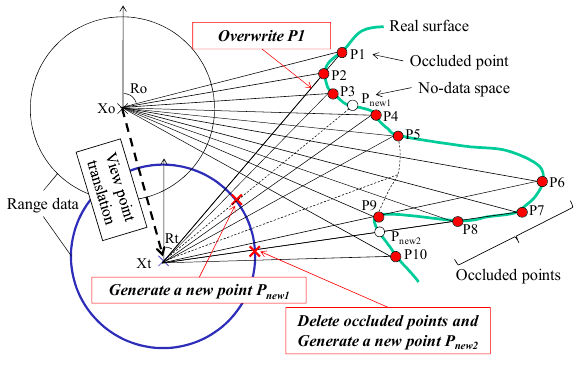
Figure 4. Point distribution calculated by viewpoint translation in the range data, occlusion detection using the point cloud, and point-cloud interpolation using distance information Filtering using distance values between a viewpoint and measured points